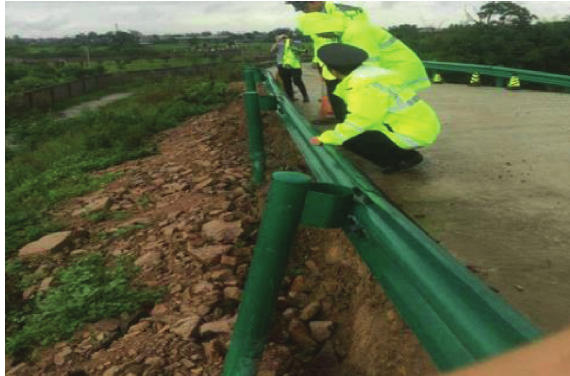
Figure 2: Partial subgrade instability (copy from